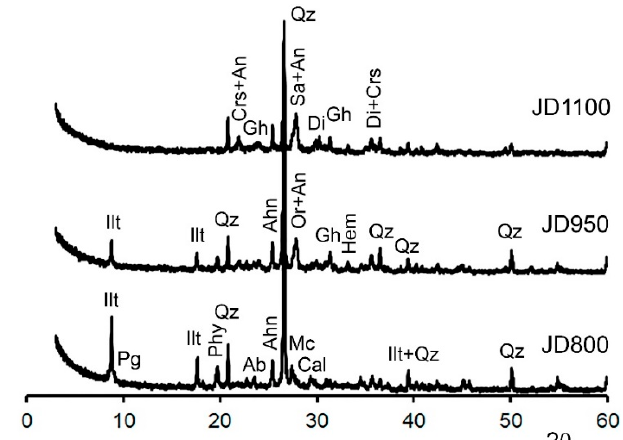
Figure 4. X ray diffraction patterns of bricks with added calcined diatomite sludge (JD) fired at 800 ◦ C, 950 ◦ C, and 1100 ◦ C. Legend: Qz = quartz, Ilt = illite/muscovite; Pg = paragonite; Phy: phyllosilicates (in general); Cal = calcite; Ahn = anhydrite; Hem = hematite; Mc = microcline; Or = orthoclase; Sa = sanidine; Ab = albite; An = anorthite; Gh = gehlenite; Di = diopside; Crs = cristobalite. Minerals abbreviations after Whitney and Evans [55].